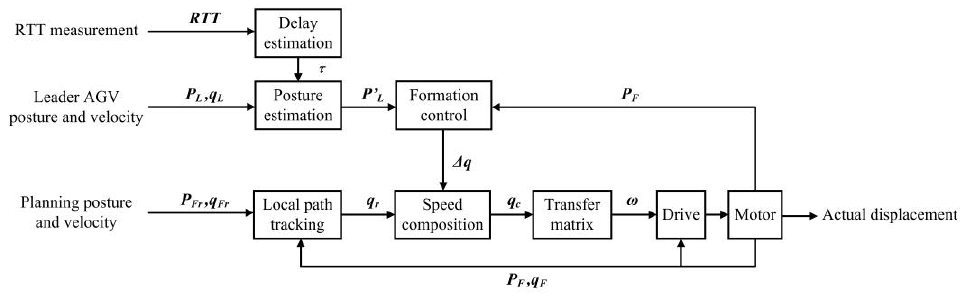
Figure 7. Control system structure of follower AGV.